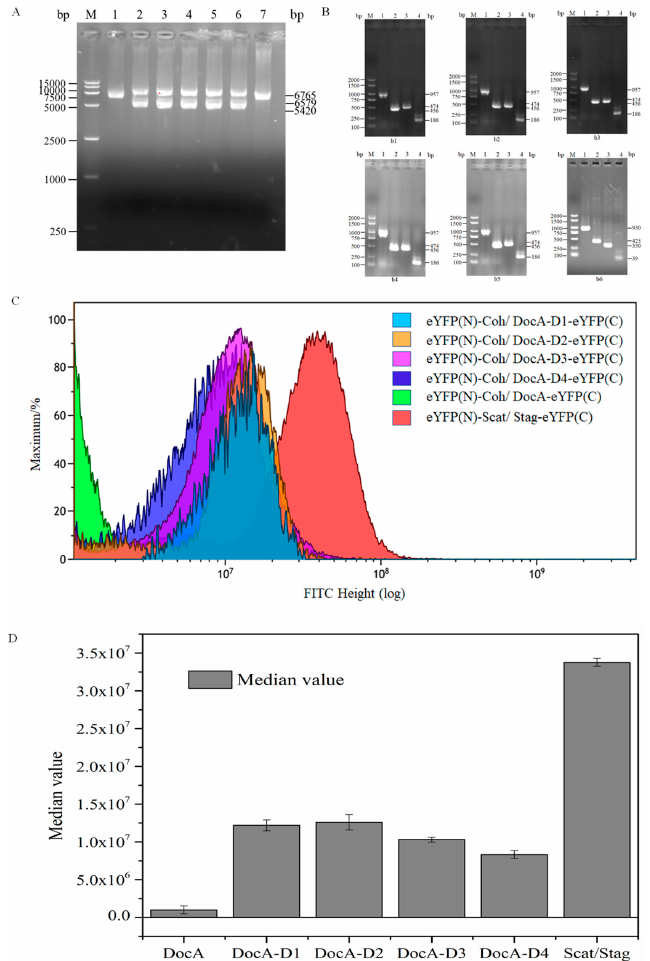
Figure 3. In vivo fluorescence verification of the binding of DocA mutants to Coh. ( A ) Verification of the recombinant plasmids for the fusion protein eYFP-DocA mutants/Coh. M: marker DL15000; 1: 5420 bp DNA of pETDuet-1; 2: 6765 bp DNA of pETDuet-1-eYFP(N)-Coh/DocA-eYFP(C); 3: 6765 bp DNA of pETDuet-1-eYFP(N)-Coh/DocA-D1-eYFP(C); 4: 6765 bp DNA of pETDuet-1-eYFP(N)-Coh/DocA-D2-eYFP(C); 5: 6765 bp DNA of pETDuet-1-eYFP(N)-Coh/DocA-D3-eYFP(C); 6: 6765 bp DNA of pETDuet-1-eYFP(N)-Coh/DocA-D4-eYFP(C); 7: 6579 bp DNA of pETDuet-1-eYFP(N)-SpyCatcher/SpyTag-eYFP(C). ( B ) Verification of the mutant protein engineering strains. PCR product of the mutant gene. (b1) M: marker DL2000; 1: 957 bp DNA fragment of fusion eYFP(N)-Coh gene; 2: 456 bp DNA fragment of Coh gene; 3: 474 bp DNA fragment of fusion DocA-eYFP(C) gene; 4: 186 bp DNA fragment of DocA gene. (b2) M: marker DL2000; 1: 957 bp DNA fragment of fusion eYFP(N)-Coh gene; 2: 456 bp DNA fragment of Coh gene; 3: 474 bp DNA fragment of fusion DocA- D1-eYFP(C) gene; 4: 186 bp DNA fragment of DocA-D1 gene. (b3) M: marker DL2000; 1: 957 bp DNA fragment of fusion eYFP(N)-Coh gene; 2: 456 bp DNA fragment of Coh gene; 3: 474 bp DNA fragment of fusion DocA-D2-eYFP(C) gene; 4: 186 bp DNA fragment of DocA-D2 gene. (b4) M: marker DL2000; 1: 957 bp DNA fragment of fusion eYFP(N)-Coh gene; 2: 456 bp DNA fragment of Coh gene; 3: 474 bp DNA fragment of fusion DocA-D3-eYFP(C) gene; 4: 186 bp DNA fragment of DocA-D3 gene. (b5) M: marker DL2000; 1: 957 bp DNA fragment of fusion eYFP(N)-Coh gene; 2: 456 bp DNA fragment of Coh gene; 3: 474 bp DNA fragment of fusion DocA-D4-eYFP(C) gene; 4: 186 bp DNA fragment of DocA-D4 gene. (b6) M: marker DL2000; 1: 930 bp DNA fragment of fusion eYFP(N)-SpyCatcher gene; 2: 423 bp DNA fragment of SpyCatcher gene; 3: 330 bp DNA fragment of fusion SpyTag-eYFP(C) gene; 4: 39 bp DNA fragment of SpyTag gene. ( C ) Fluorescence signal intensity changes in eYFP-DocA mutants/Coh expressed via BiFC-FC fusion. ( D ) Median value of fluorescence signal intensity of eYFP-DocA